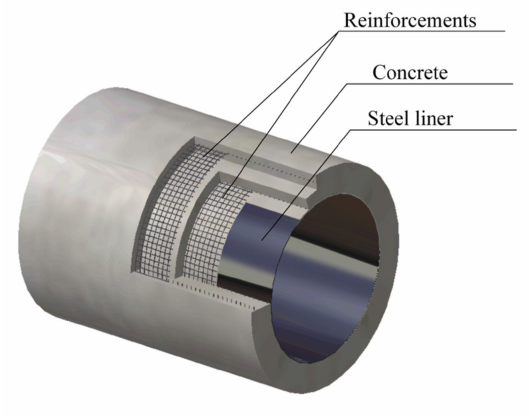
Figure 1. Schematic of the steel-lined reinforced concrete